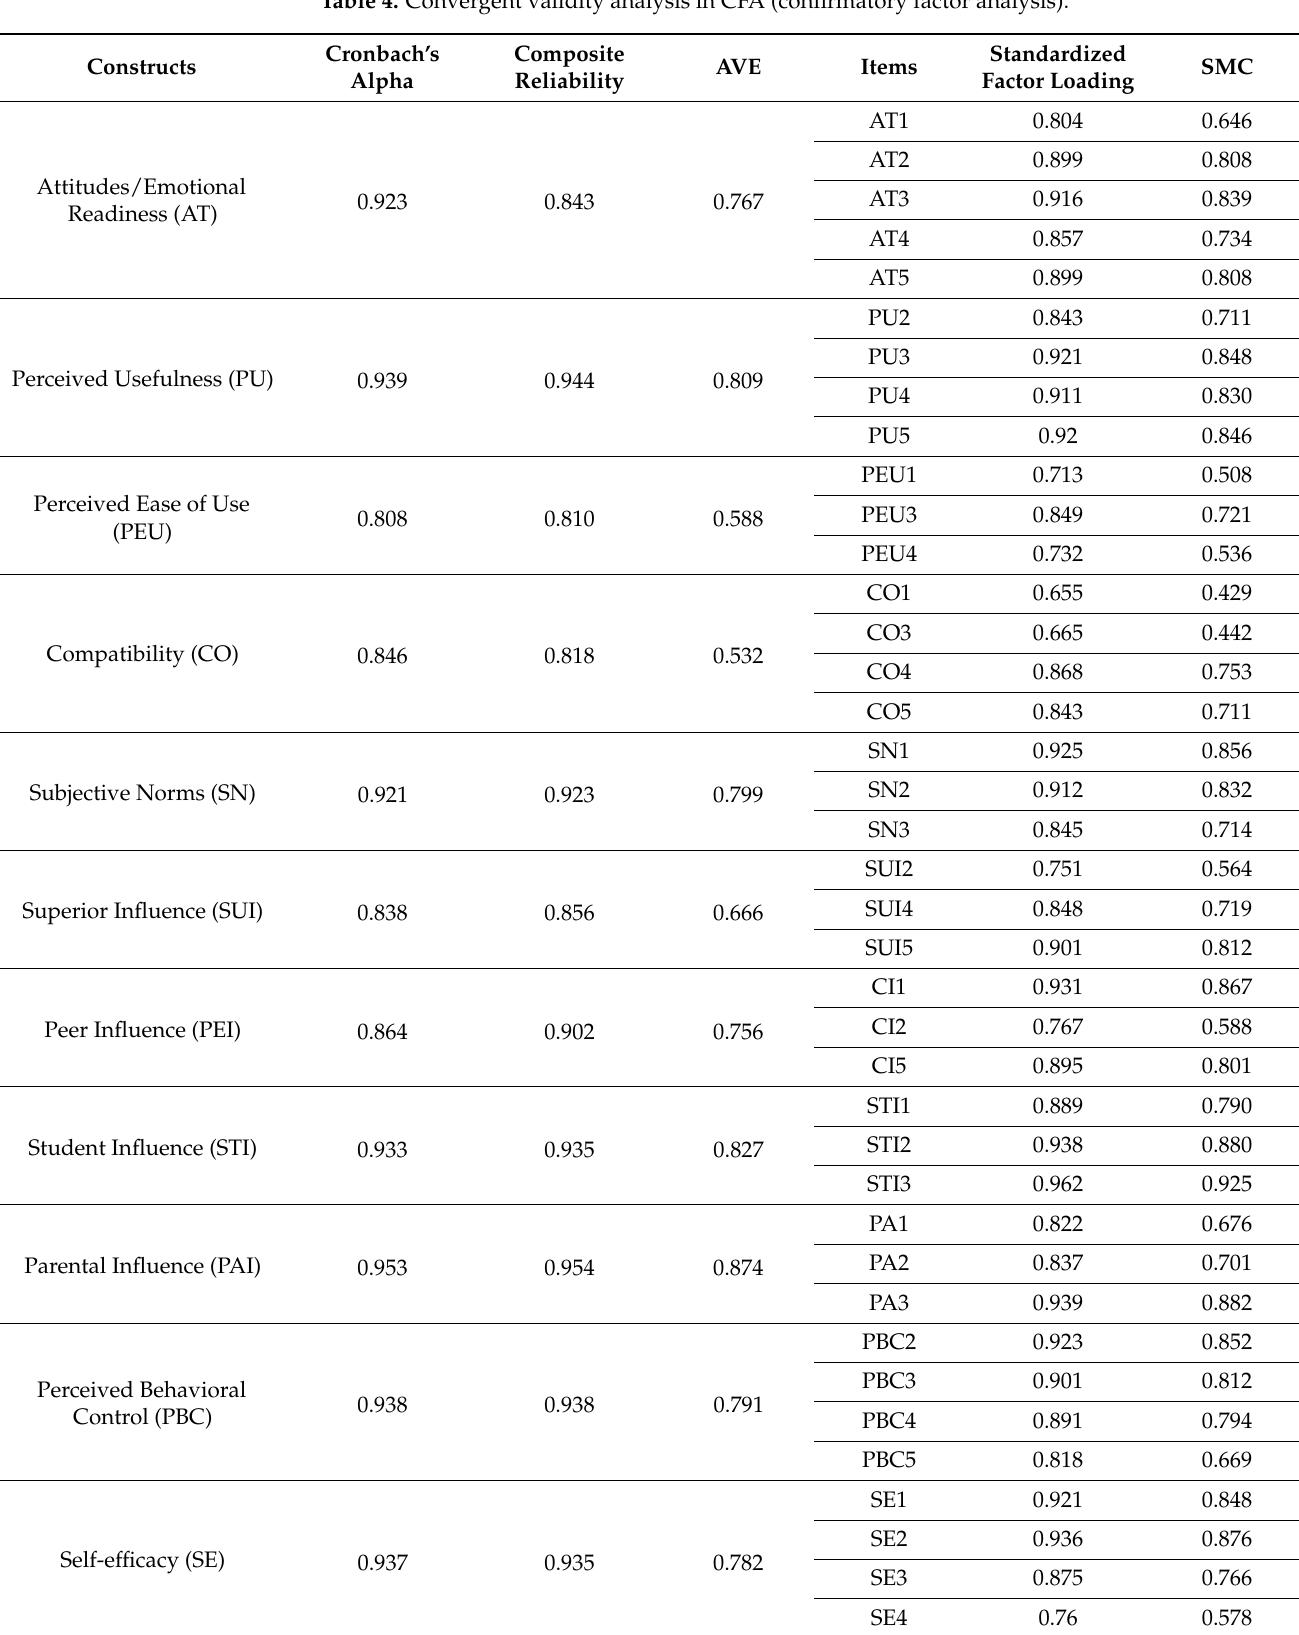
Table 4. Convergent validity analysis in CFA (confirmatory factor